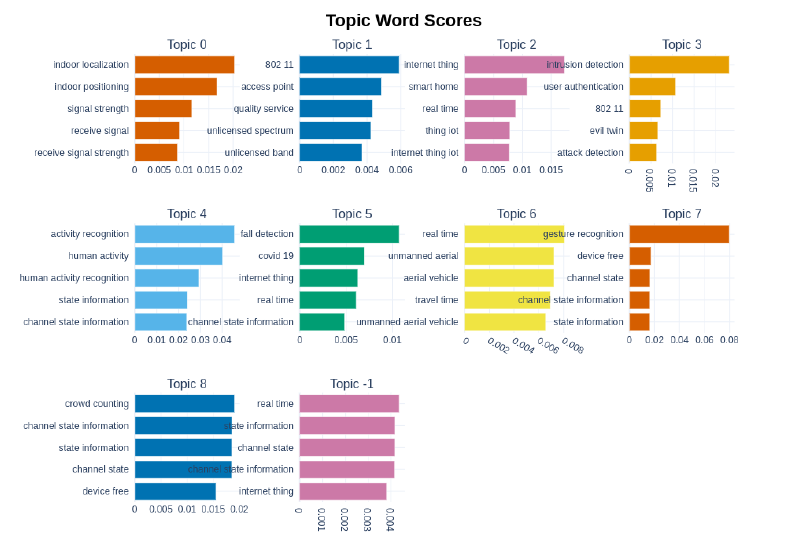
Figure 5. List of the topics with the most relevant terms (ordered by